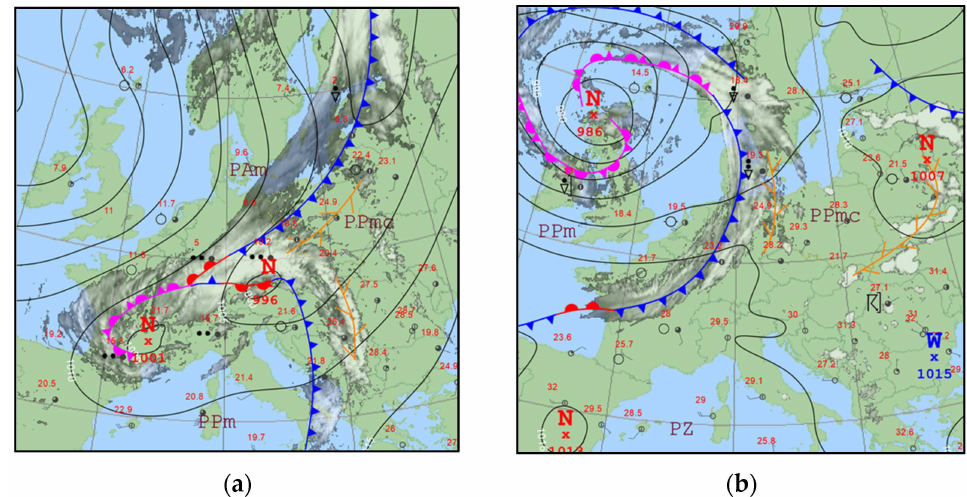
Figure 3. Synoptic maps from IMGW-PIB for the situations of: ( a ) 11 May 2020; and ( b ) 28 June 2020 (cold front).